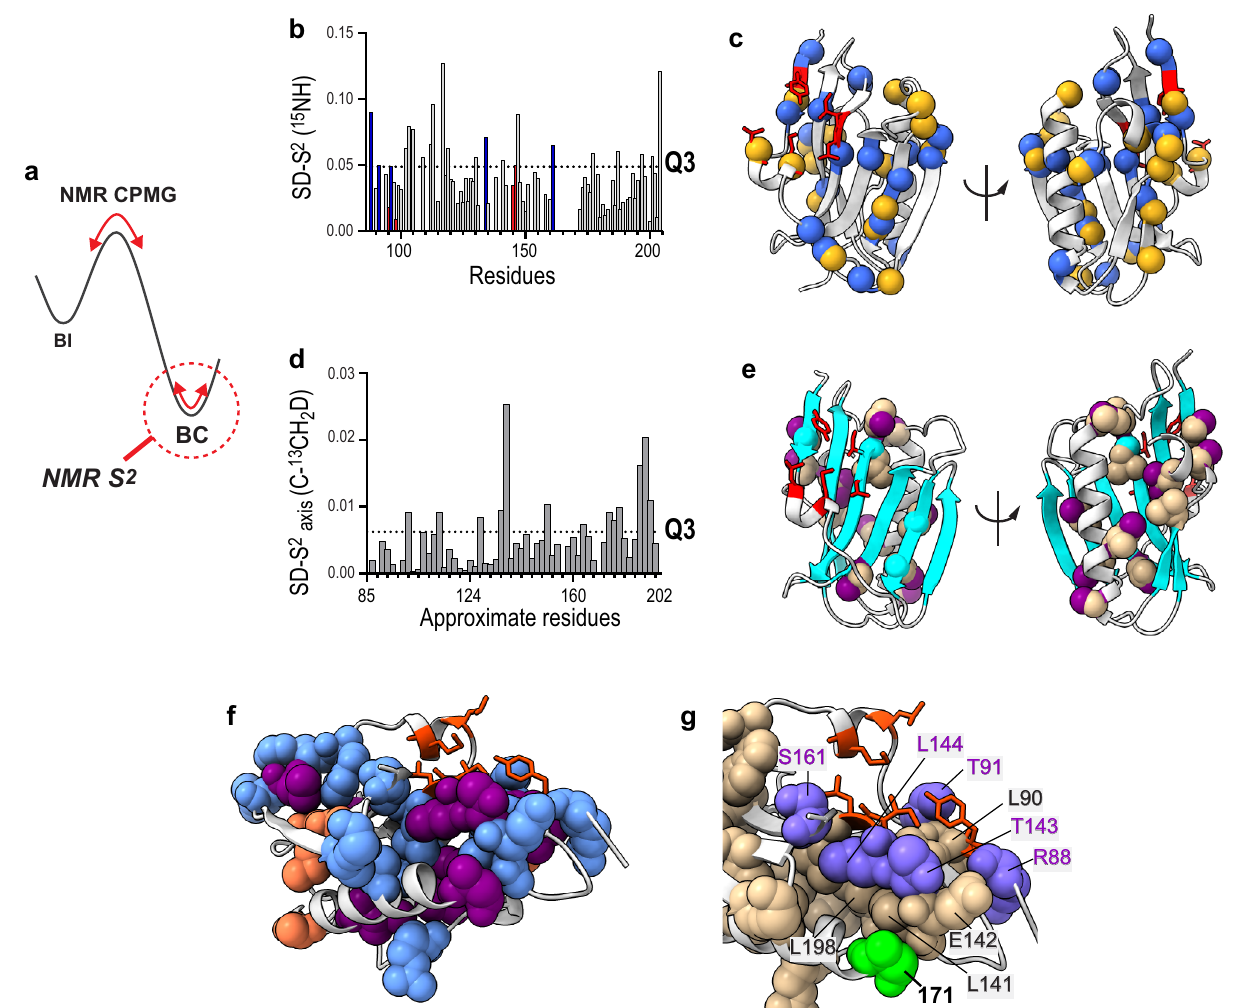
Fig.7|VariationinconformationaldynamicsduringNS1evolution.a Schematic showing the energy landscape mapping by NMR CPMG-RD and S 2 analyses. b Standard deviation(SD)of backboneS 2 NH valuesacquiredforfourNS1s.Redand blue bars correspond to core and rim interface residues, respectively. Dotted line represents Q3. c Residues whose SD-S 2 NH >Q3 are shown as blue spheres. Strain- speci fi c mutational sites are shown in yellow spheres. Core interface residues are shown in red sticks. d SD of methyl axis order parameter (S 2 axis ) acquired for four NS1s. b , d The exact sample size (n) for individual residues varies owing to peak overlap and variations in peak intensities. The sample sizes for individual residues are provided as a Source data fi le. Dotted line represents Q3. Note that x -axis corresponds to approximate residue number due to space limitation. The same